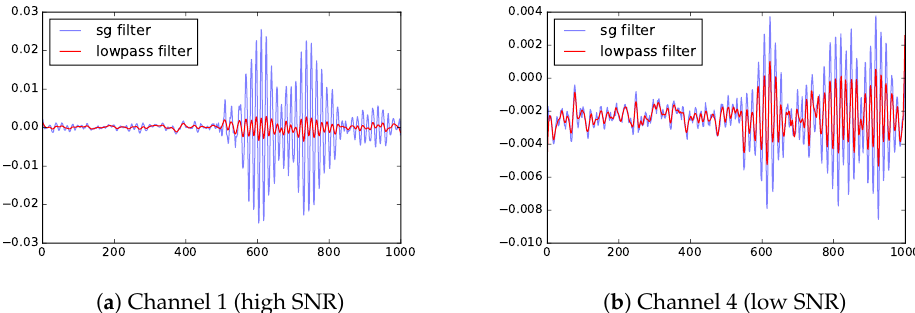
Figure 6. Savitzky–Golay (SG) filter works considerably better than low-pass filter. The horizontal axis is time steps (where each step is 0.4 ns) and the vertical axis shows UHF measurements processed with different techniques (in